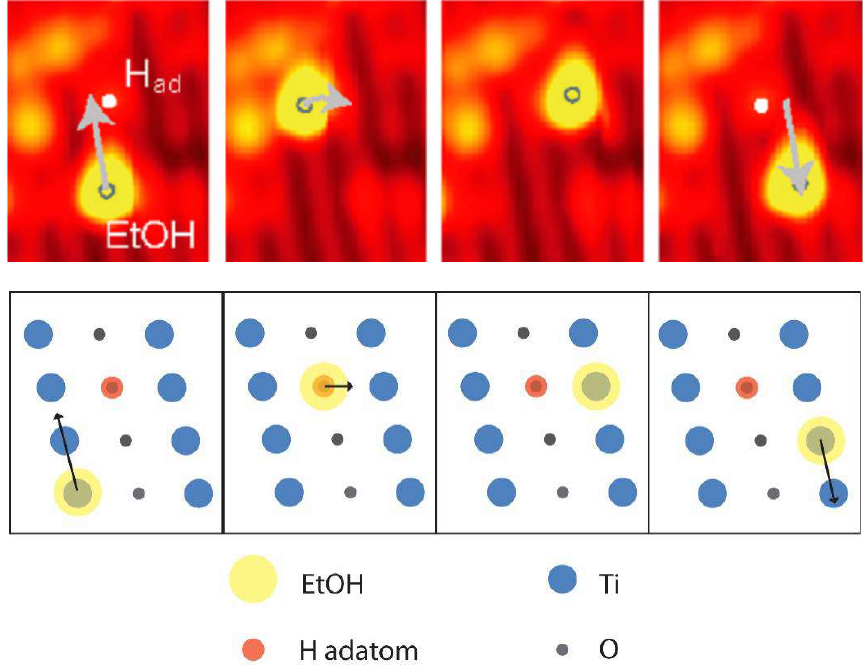
Figure 3. STM snapshots recording EtOH diffusion along and perpendicular Ti row ( upper row ) (Reprinted figure with permission from [54] Copyright (2012) by the American Chemical Society). Corresponding ball model scheme ( lower row ).